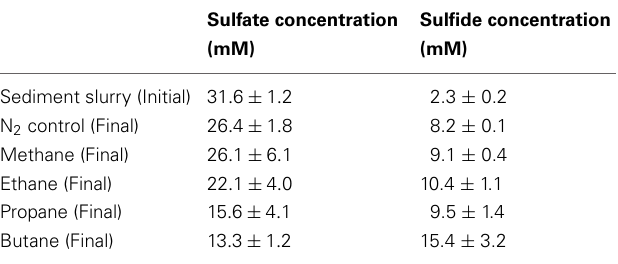
Table 4 | Comparing rate of alkane oxidation and sulfate reduction, and the effect of molybdate on alkane oxidation.